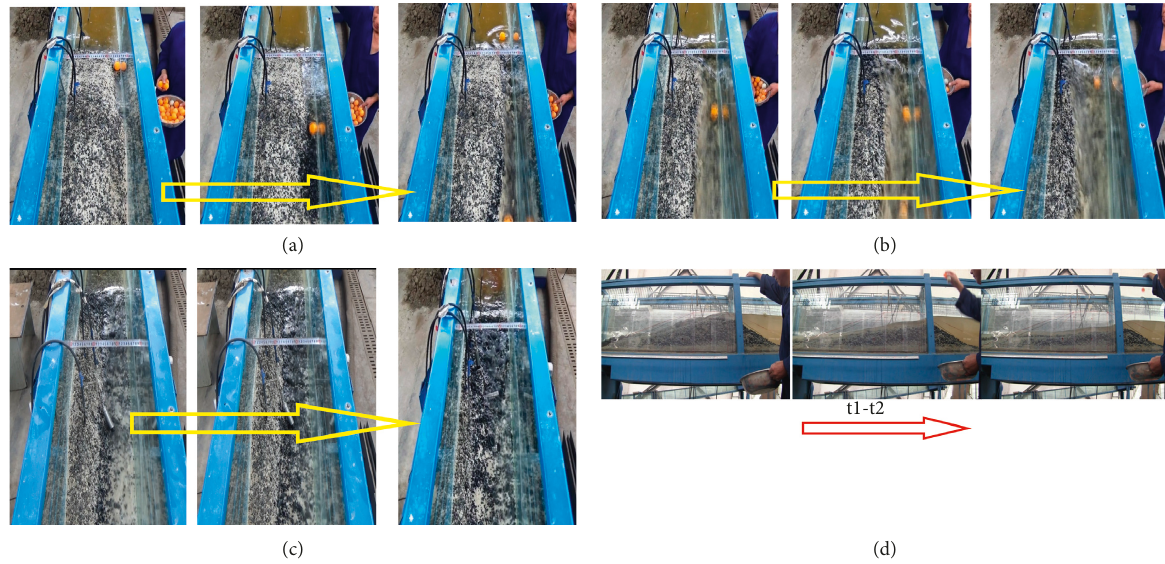
Figure 4: Images of dam and flow at different times, showing overtopping erosion is the dominant factor for dam failure. (a) Stage I for dam failure process, 0-t1 period. (b) Stage II for dam failure process, t1-t2 period. (c) Stage III for dam failure process, t2-t3 period. (d) The longitudinal profiles of the dam in Stage II. It shows a whole backward erosion process.